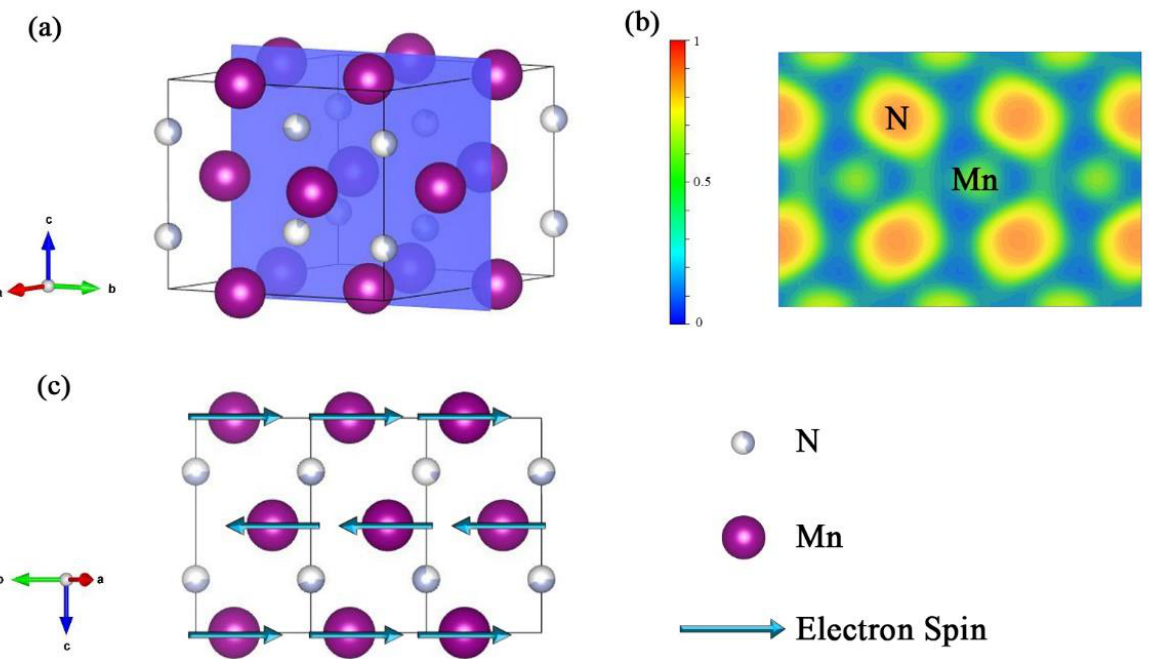
Figure 8. ( a ) The cutting slab of Mn 2 N 0.86 along the (100) plane. ( b ) ELF of Mn 2 N 0.86 2D display for (100) plane. ( c ) Magnetic structure of Mn 2 N 0.86 projected.